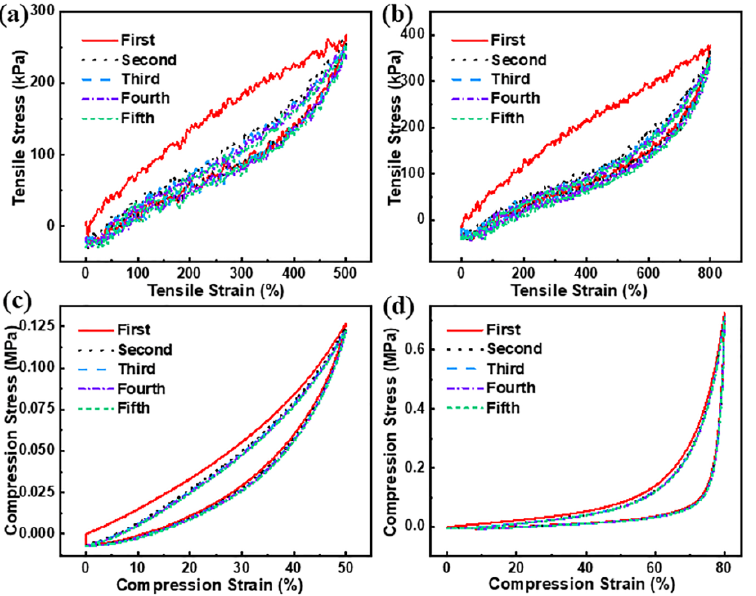
Figure 5. Cyclic tensile loading–unloading curves of M 3 /G/PAM NDN hydrogel at strain of ( a ) 500%, ( b ) 800%; cyclic compression loading–unloading curves of M 3 /G/PAM NDN hydrogel at strain of ( c ) 50%, ( d ) 80%. Table 3. Comparison of the mechanical properties of MXene-based nanocomposite hydrogels. Hydrogel